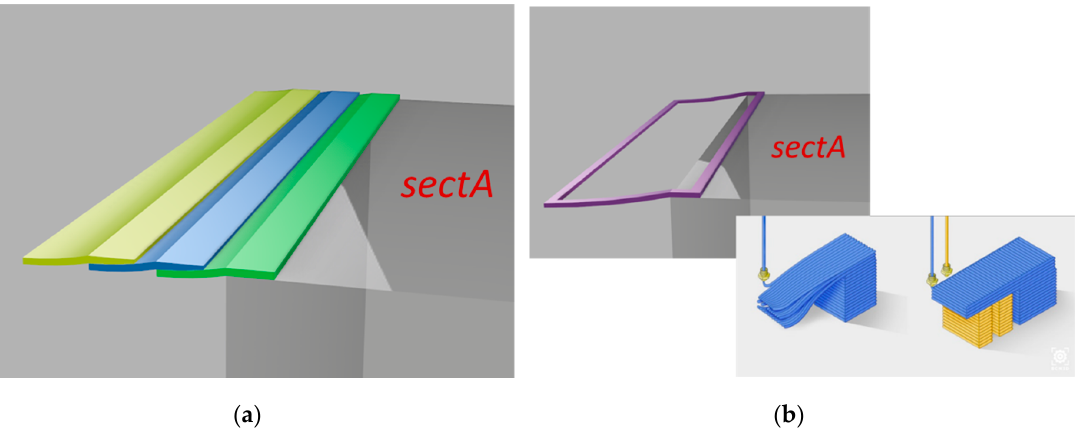
Figure 7. Comparison between proposed algorithm and typical slicing result. ( a ) Overlapping procedure of proposed method; ( b ) supportfree result without proposed method and nonfree-support results.